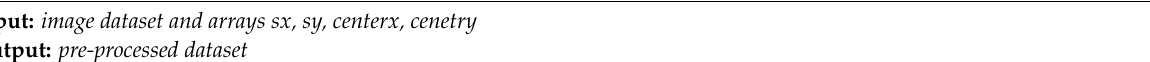
Algorithm 2: Statistical radial scanning of